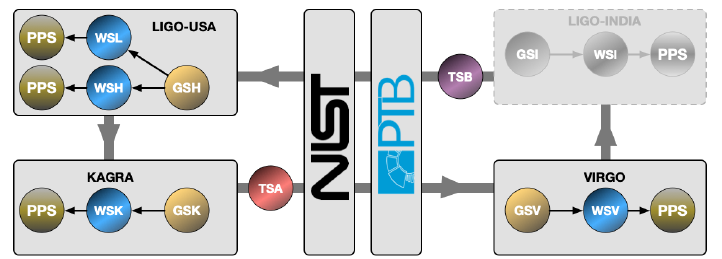
Figure 4. Proposed global network calibration scheme using two transfer standards, TSA and TSB, to deliver laser power calibration from NIST and PTB to each observatory. Local Gold Standards (GSi) and Working Standards (WSi) are then used to transfer the calibrations to Pcal power sensors (PPS) at the end stations. The LIGO, Virgo, and KAGRA detectors are expected to participate in this scheme during the O4 observing run. The LIGO-India detector is expected to participate in subsequent observing